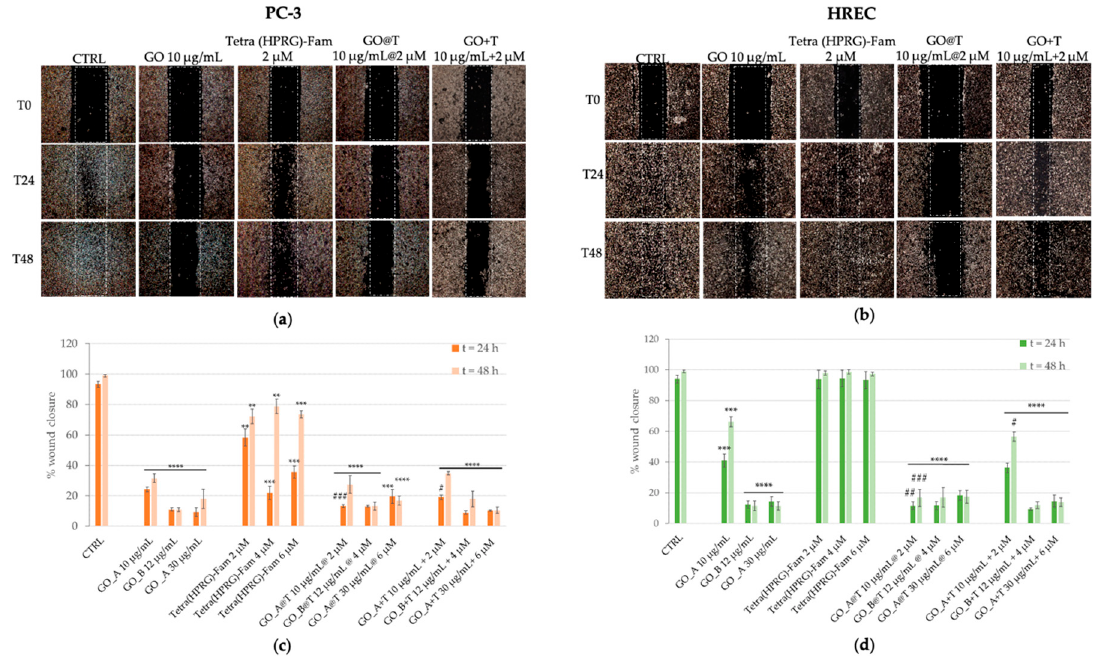
Figure 6. Representative micrographs ( a , b ) and quantitative analysis of cell migration ( c , d ) for prostate cancer ( a , c ) and endothelial ( b , d ) cells in absence (negative control, CTRL) or in presence of the different treatments at time 0, 24 h and 48 h after scratch: GO nanosheets (10, 12, 30 µg/mL), Tetra(HPRG)-Fam peptide (2, 4, 6 µM), GO@T hybrids (10 µg/mL 2 µM, 12 µg/mL 4 µM, 30 µg/mL 6 µM of GOpeptide concentration) and GO+T mixtures. PC-3 and HREC cells were wounded as described in the Materials and Methods section. The quantitative analysis of migration assay (wound edge advancement in percent vs. time) is expressed as means values (± SEM) from three independent experiments. Statistical analysis was performed by pairwise Student’s T -test results are expressed as percentage of wound closure with respect to time 0. (**) p < 0.01, (***) p < 0.001, (****) p < 0.0001 vs. CTRL, ( # ) p < 0.05, ( ## ) p < 0.01, ( ### ) p < 0.001 vs. the corresponding GO reference sample. Table 1. Prostaglandin (PGE 2 ) production in PC-3 medium, after different treatments. Values (means ± SEM) are from three independent experiments ( n = 3). ANOVA was used to compare PGE2 production in all experimental conditions. * p < 0.01 vs. control cells. PC-3 Treatment PGE 2 (pg/mL) CTRL